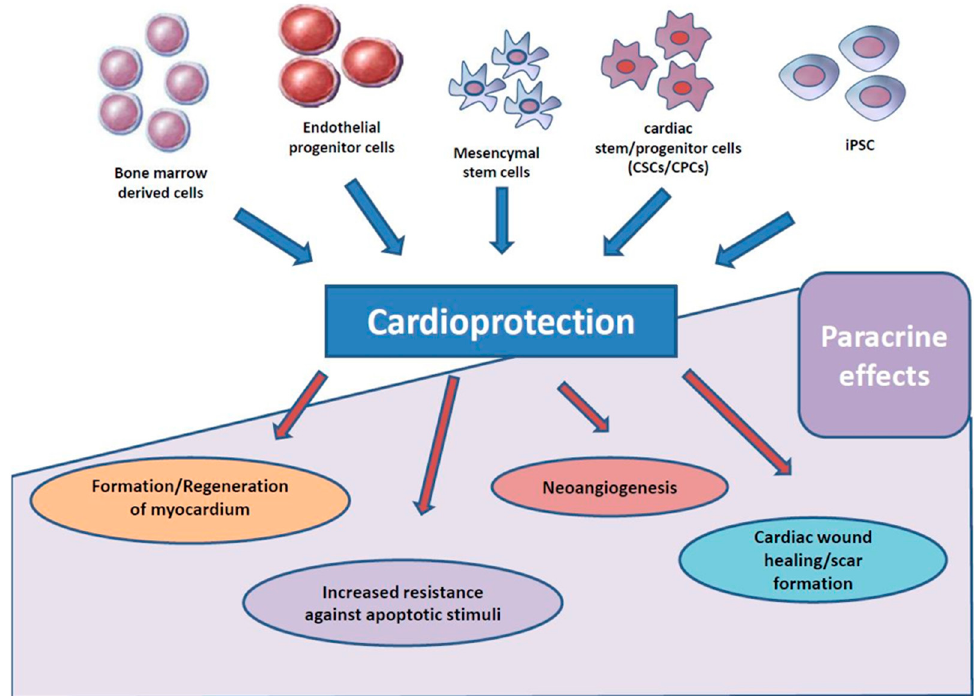
Figure 1. Comorbidities, timepoint of harvesting, cell separation methods, distinct media, additives, and distinct modes of delivery might contribute to distinct outcomes.